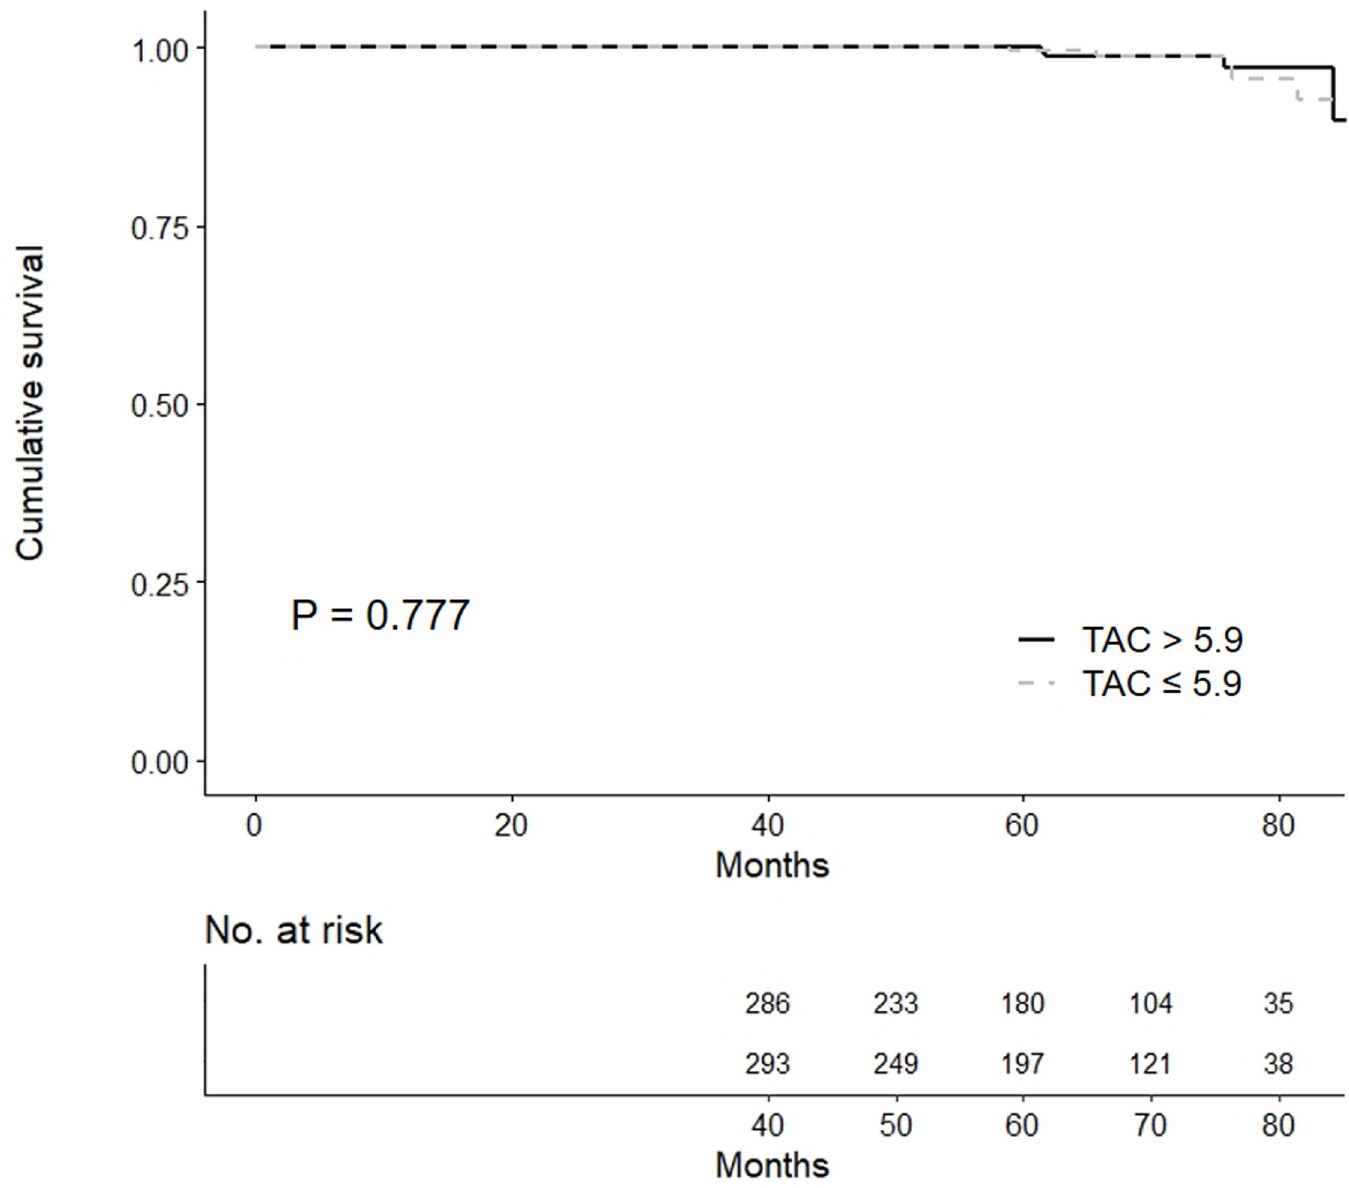
Fig 3. Development of de novo DSAs after 1 year post-transplant according to TAC trough levels. No significant difference in de novo DSA development between the HL-TAC and LL-TAC groups was observed in the Kaplan-Meier plot. Abbreviations: DSA, donor-specific anti-HLA antibody; LL, low-level; HL, high-level; TAC,